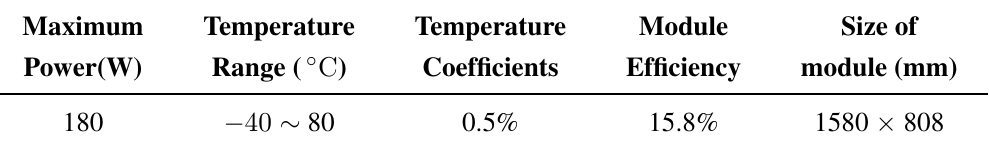
Table 2. Specifications of PV arrays used in the